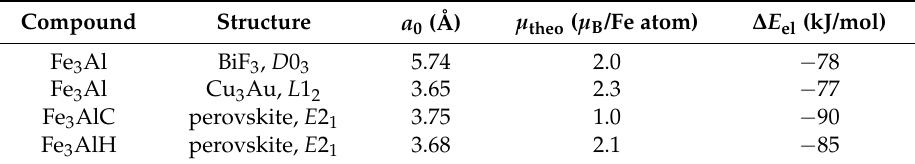
Table 1. Lattice parameter a , magnetic saturation moments μ theo and formation energies Δ E el at T = 0 K of various compounds related to the κ -phase.